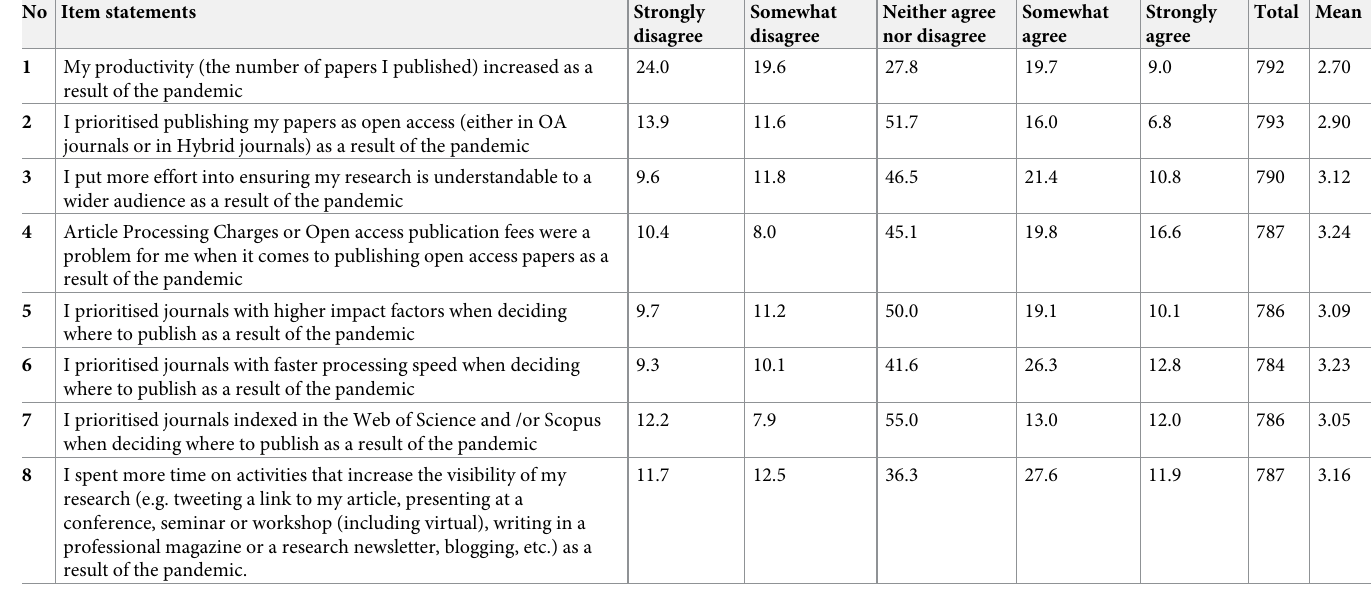
Table 7. Think of your current publishing practices in comparison with practices before the pandemic and tell us to what extent you agree or disagree with each statement